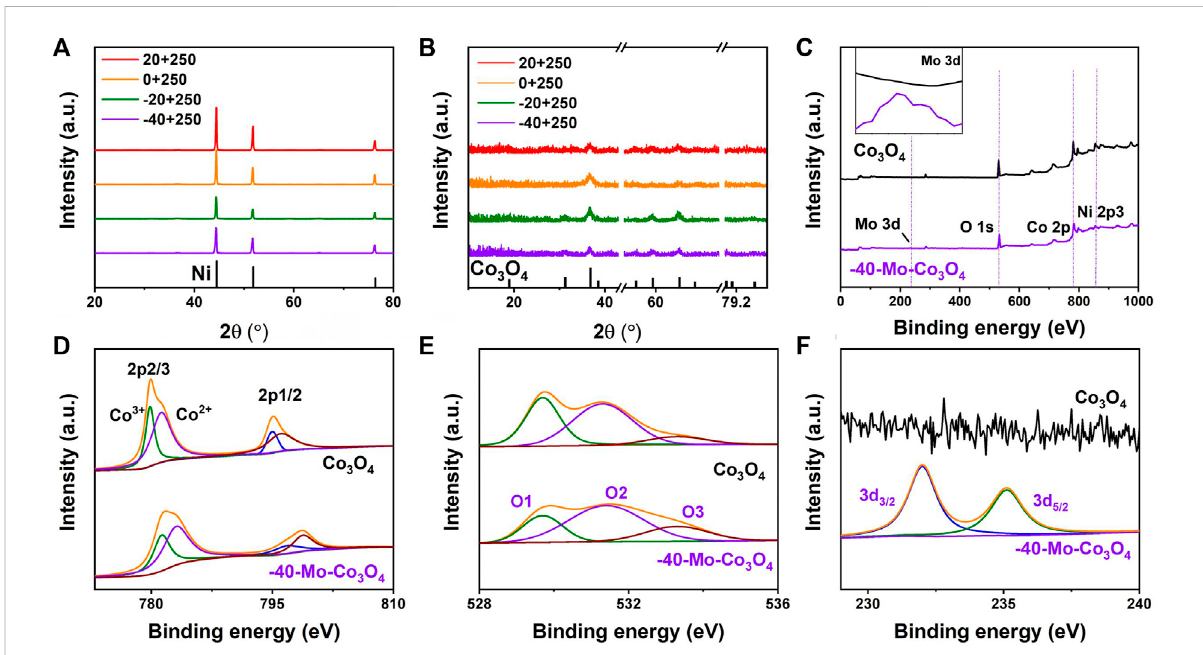
FIGURE 4 (A,B) XRD patterns of Mo-Co 3 O 4 at different cooling temperatures (heated at 250 ° C), (C) XPS spectra of survey for Co 3 O 4 and Mo-Co 3 O 4 (heated at 250 ° C, quenched at -40 ° C), XPS spectra of (D) Co 2p, (E) O 1s, and (F) Mo 3 days for Mo-Co 3 O 4 (heated at 250 ° C, quenched at − 40 °